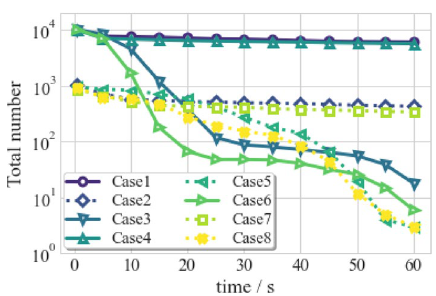
Figure 23. Total number of droplets varies with